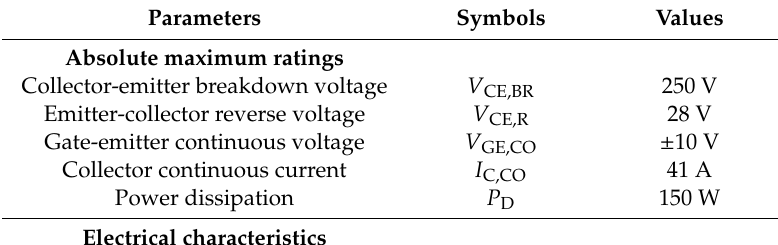
Table 7. FGD3325G2-F085 IGBT (S1-S6) specifications.